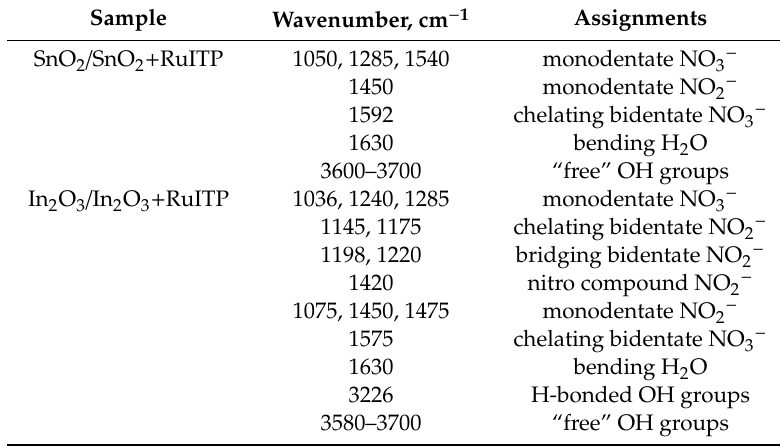
Table 3. Assignments of IR bands (cm − 1 ) appeared in DRFIT spectra as a result of NO adsorption on the surface of prepared samples at room temperature according to